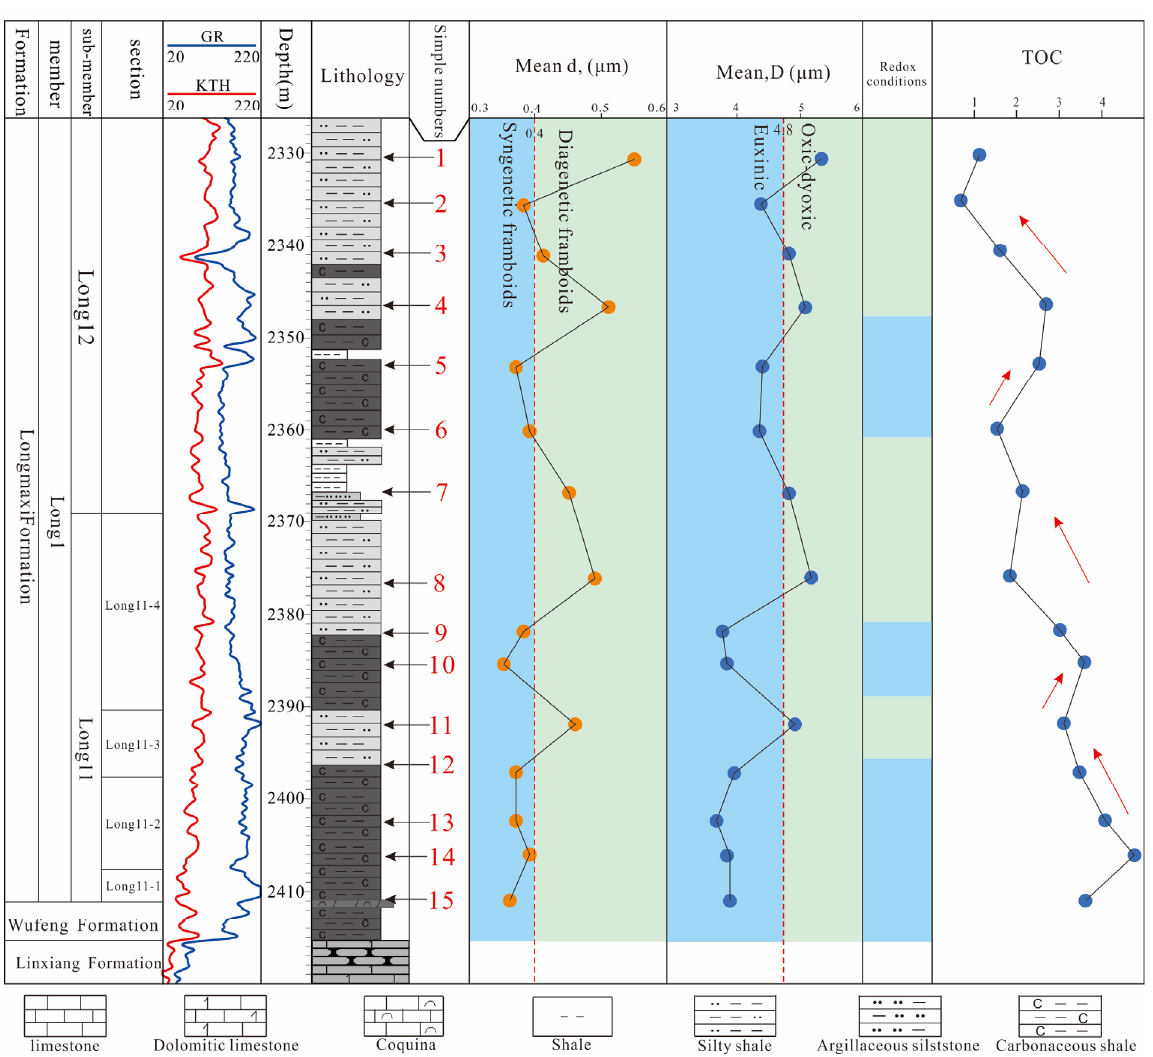
Figure 8. The mean, D, mean, d, redox condition variations and TOC of the Wufeng–Longmaxi marine shale of the JY1 well in the Jiaoshiba area, southeast Sichuan Basin.